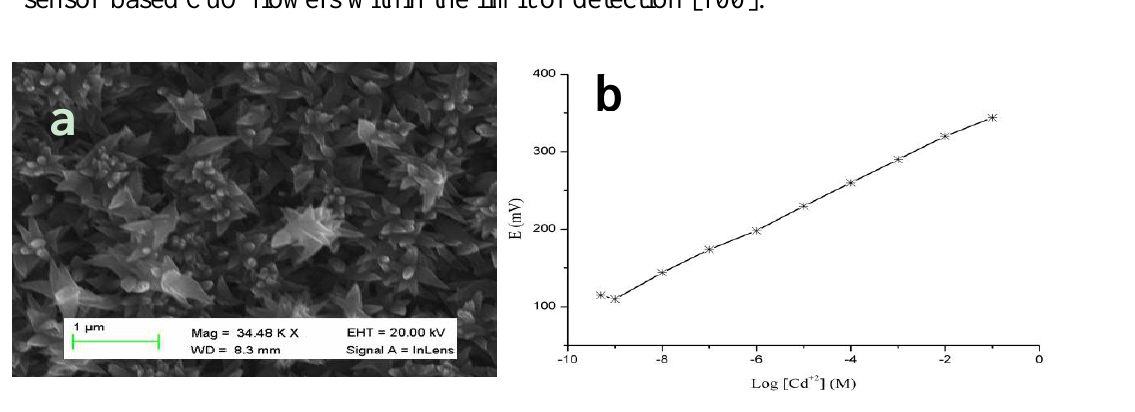
Figure 11. ( a ) SEM image of CuO nanoflowers and ( b ) calibration curve of cadmium ion sensor-based CuO flowers within the limit of detection